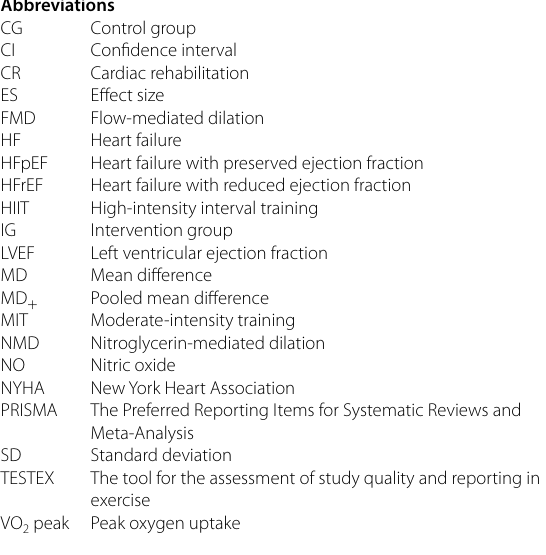
Table S2 . Intervention and assessment characteristics. Table S3 . Meth‑ odological quality assessment of included studies judged using TESTEX scale. Table S4 . Analyses of the influence of potential moderator variables on the effect of exercise‑based cardiac rehabilitation on relative flow‑ mediated dilation. Figure S1 . Forest plot of mean differences between exercise‑based cardiac rehabilitation and control group for absolute flow‑ mediated dilation. Figure S2 . Forest plot of mean differences between exercise‑based cardiac rehabilitation and control group for relative nitroglycerin‑mediated